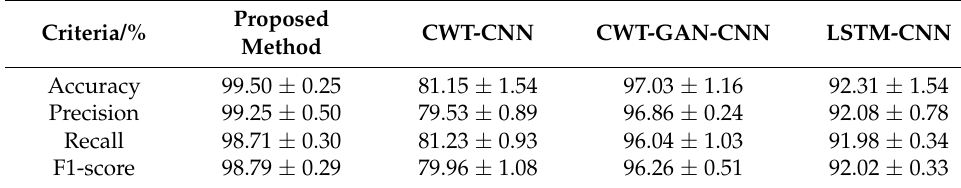
Table 7. Evaluation indicators for different